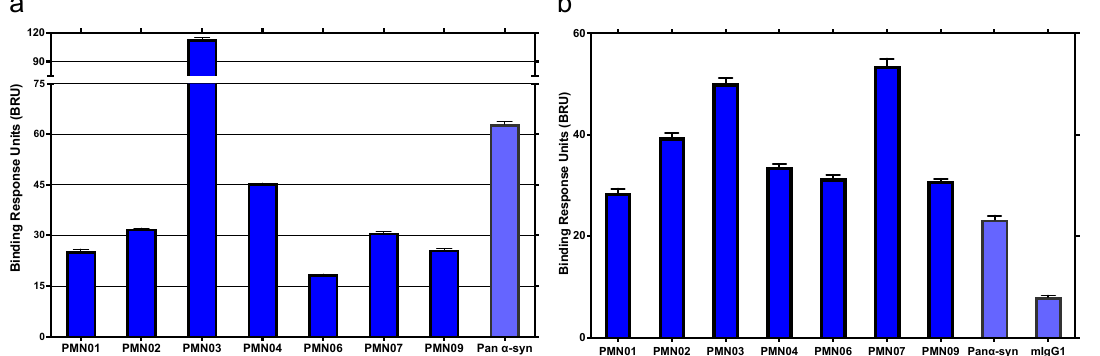
Figure 7. Binding of mAbs to native pathogenic α -syn species in patient brain extract. The binding response of immobilized mAbs to α -syn in brain extractS from DLB ( a ) and MSA ( b ) patients was measured by SPR. A pan α -syn reactive antibody and mouse IgG1 (mIgG1) were used as controls. Results shown are the mean ± SEM of 2 ( a ) or 4 ( b ) independent studies.